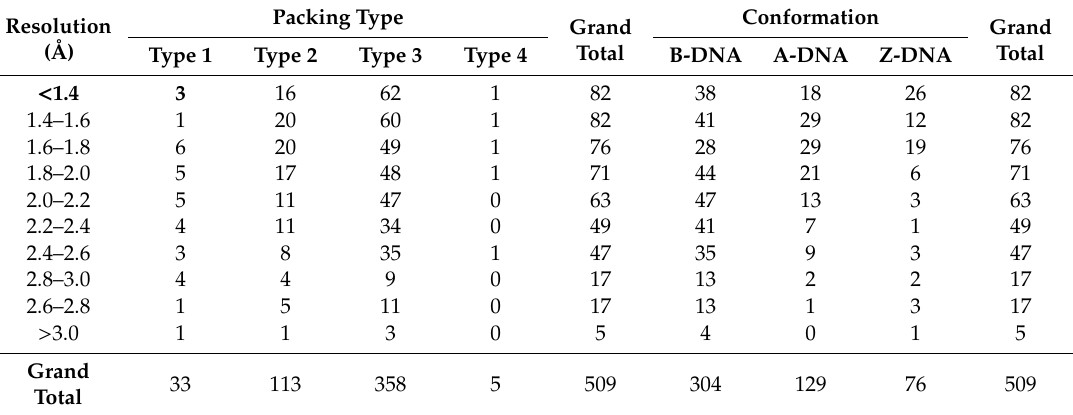
Table 4. Number of DNA structures belonging to di ff erent resolution ranges, their packing types, and conformations.